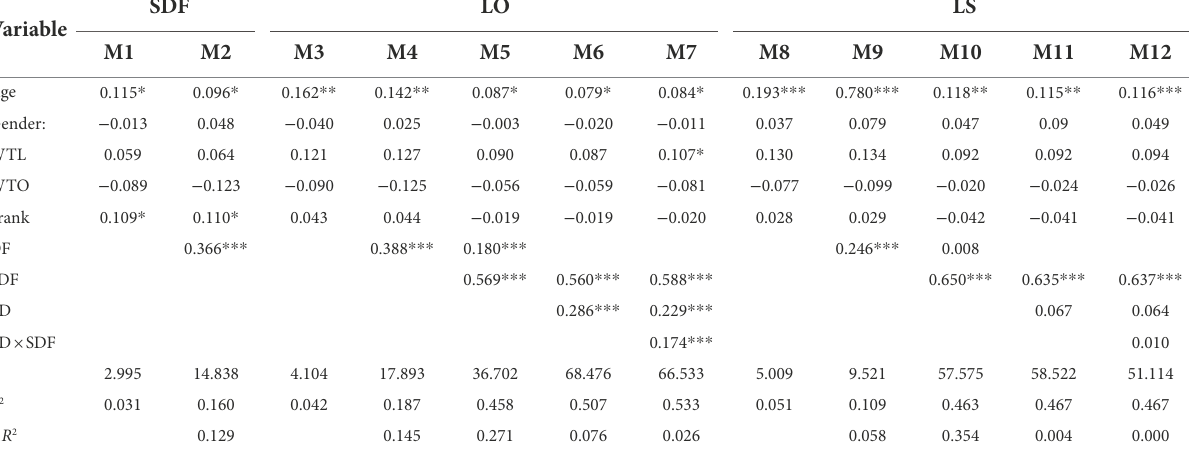
TABLE 9 Results of hierarchical regression analysis.